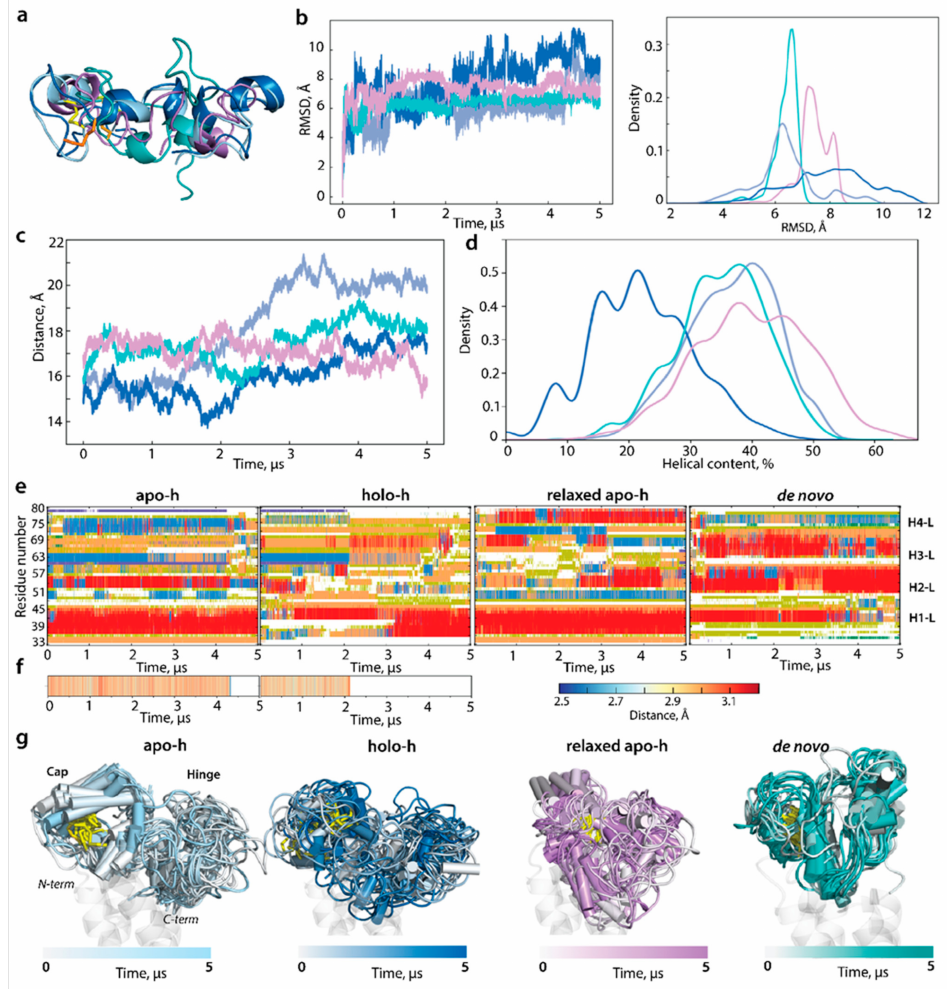
Figure 6. Structure and conformation of hVKORC1 L-loop studied as isolated polypeptide. ( a ) L-loop was extracted from apo-h and holo-h, relaxed apo-h, and de novo models and simulated (cMD) over 5 µ s. ( b ) RMSDs of each form after C α -atoms fitting to their respective initial conformations (left) and RMSD probability density (right). ( c ) Distance between L-loop ends (C α − C α atoms). ( d ) RMSFs computed for the C α atoms of each form after fitting on their respective initial conformation. ( d )